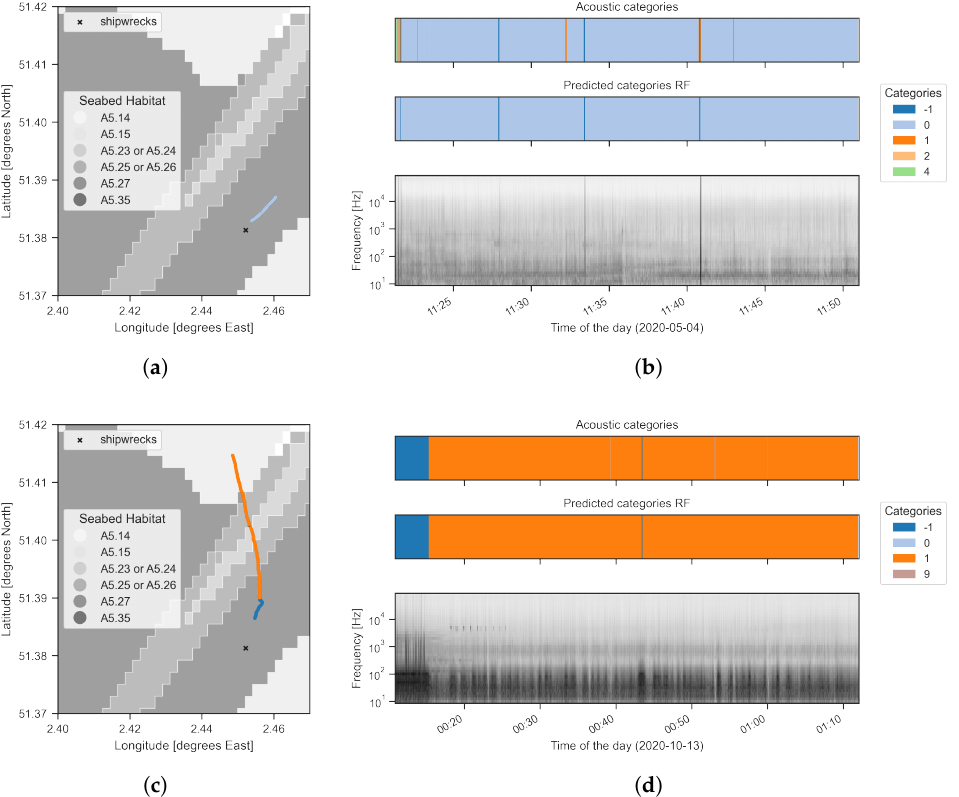
Figure 9. Deployment in spring plotted spatially ( a ) and temporally ( b ). Deployment in autumn, plotted temporally ( c ) and spatially ( d ).